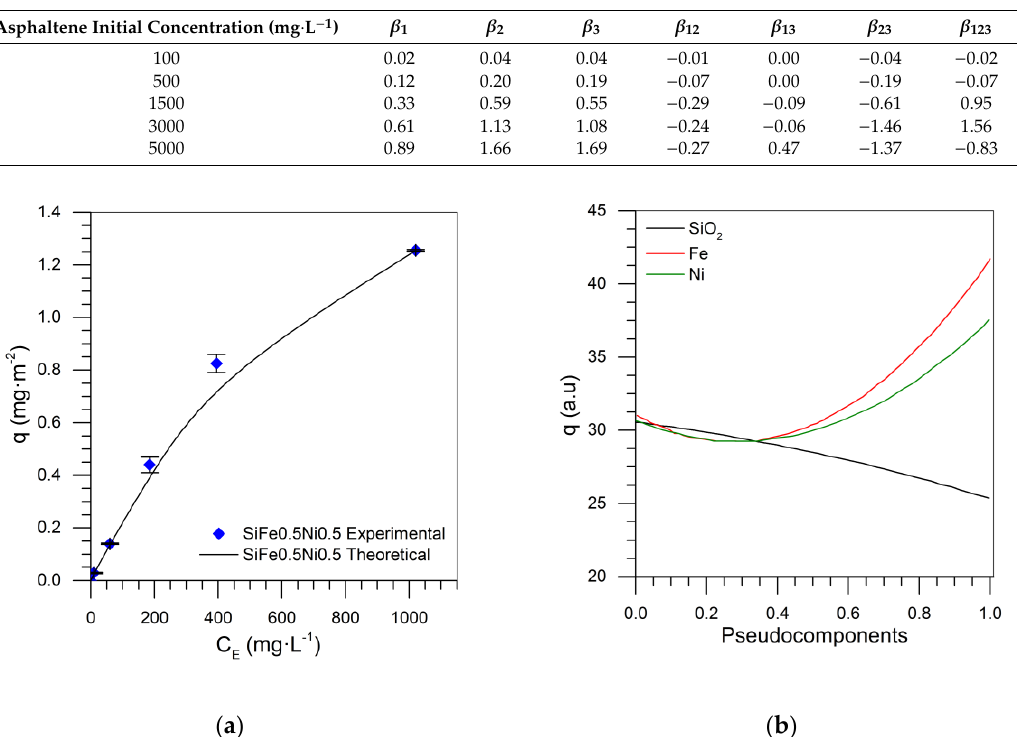
Figure 7. Response surface of the amount of adsorbed asphaltene for the Si-Fe-Ni mixture design at a concentration of 100 mg·L −1 .